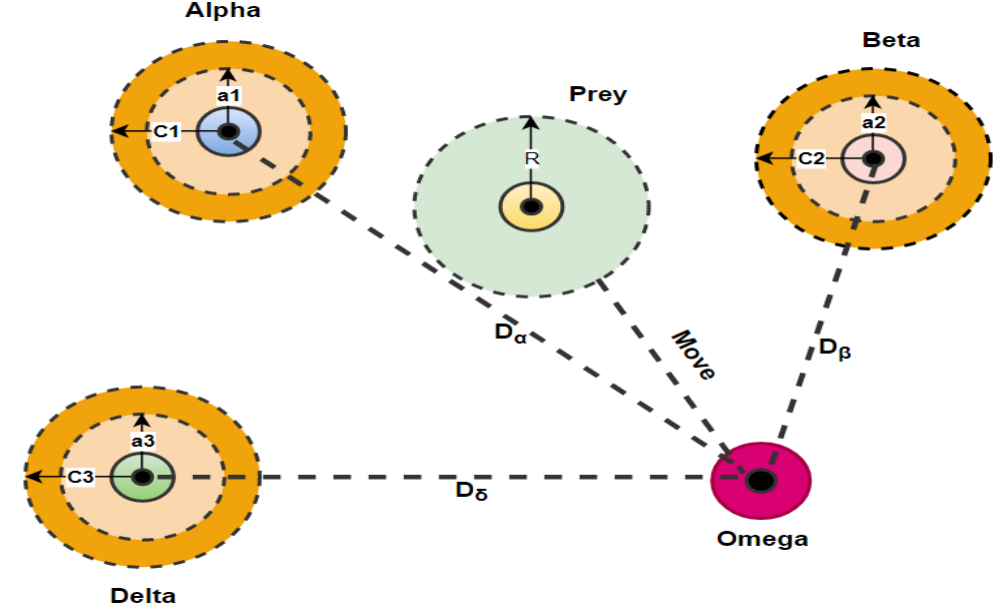
Figure 7. Positions updating in the Grey Wolf Optimizer (GWO) [26].